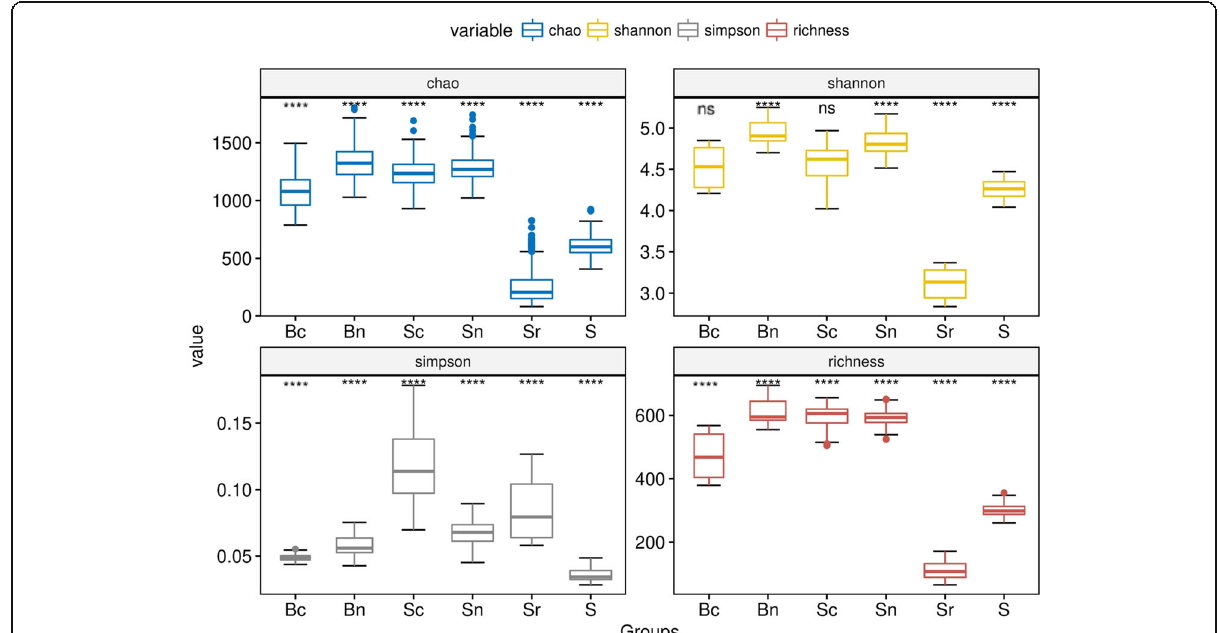
Fig. 1 Alpha diversity boxplot of all sugar beet and soil samples. Bc: sugar beet tuber of continuous cropping; Bn:sugar beet tuber of non- continuous cropping; Sc: soil of Bc; Sn: soil of Bn; Sr: rhizosphere soil of Bn; S: seeds of sugar beet. Wilcoxon method was used to compare the level of significance and P value of the differences between the samples. Pairwise comparison of each sample and the four asterisks of P value indicate P < 0.0001, and ns means the difference of Bc vs Sc was not significant